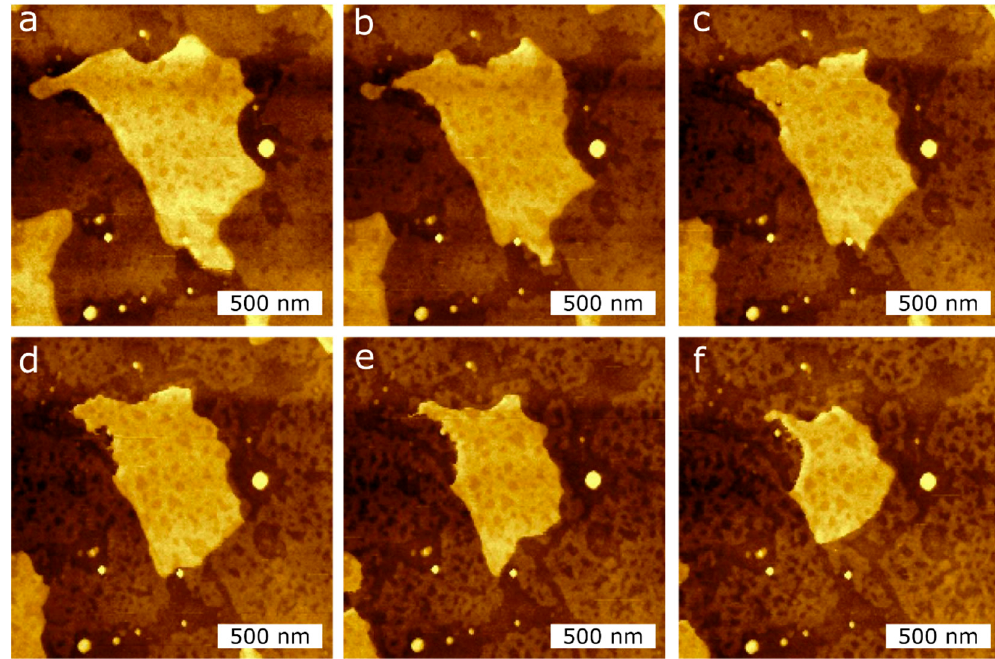
Figure 6. AFM topography images of the DPPC bilayer taken at RT in air during consecutive measurements in the same scan region (2 µm × 2 µm) to induce the reduction of the island-like DPPC bilayer surface area, applying two different tip forces, ( a – c ): 1 nN; ( d – f ): 3 nN.